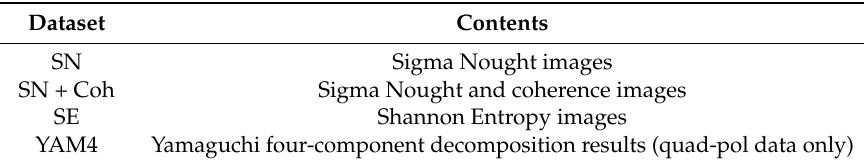
Table 3. Datasets for classification.